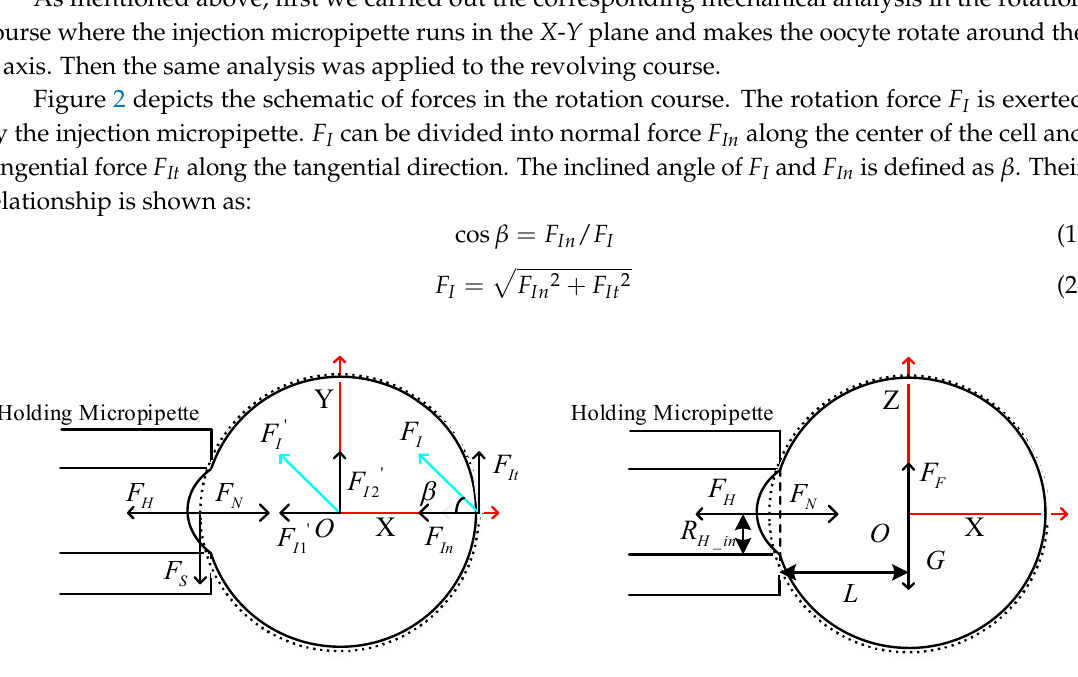
Figure 2. Initial poking direction of injection micropipette in the x axis.